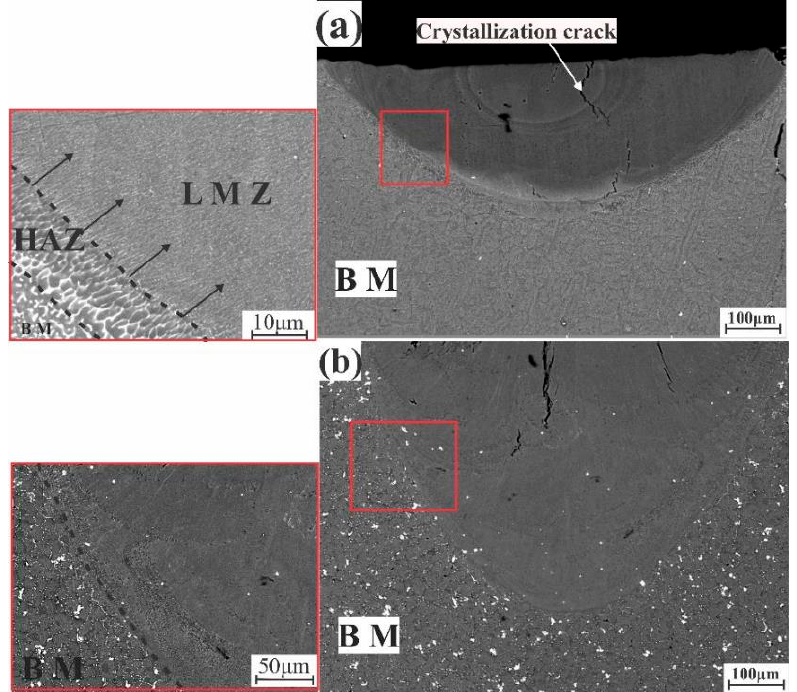
Figure 7. SEM images of the laser-melted zone (LMZ) after homogenization annealing at 460 °C for 3 h: ( a ) AA7075-standard, ( b ) AA7075-ScZr.